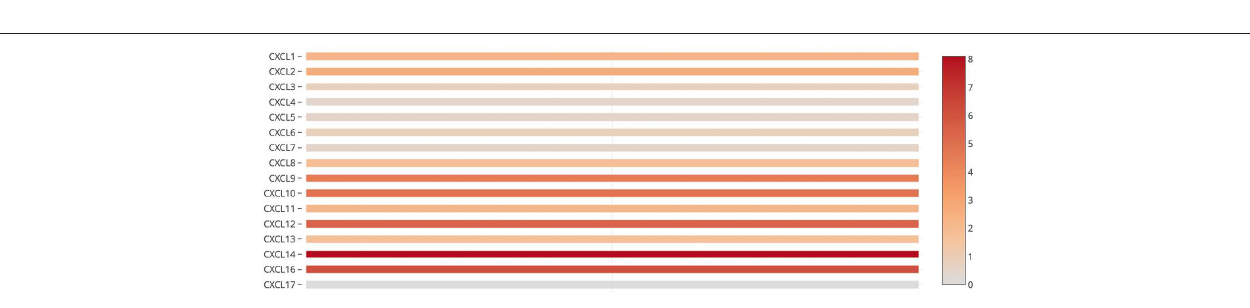
FIGURE 2 | The transcription of CXC chemokines in RCC (UALCAN). The transcriptional levels of (A) CXCL1, (B) CXCL2, (C) CXCL5, (D) CXCL9, (E) CXCL10, (F) CXCL11, (H) CXCL13, and (I) CXCL16 in RCC tissues were significantly elevated while the transcriptional levels of (G) CXCL12 were significantly reduced. The p value was set at 0.05.